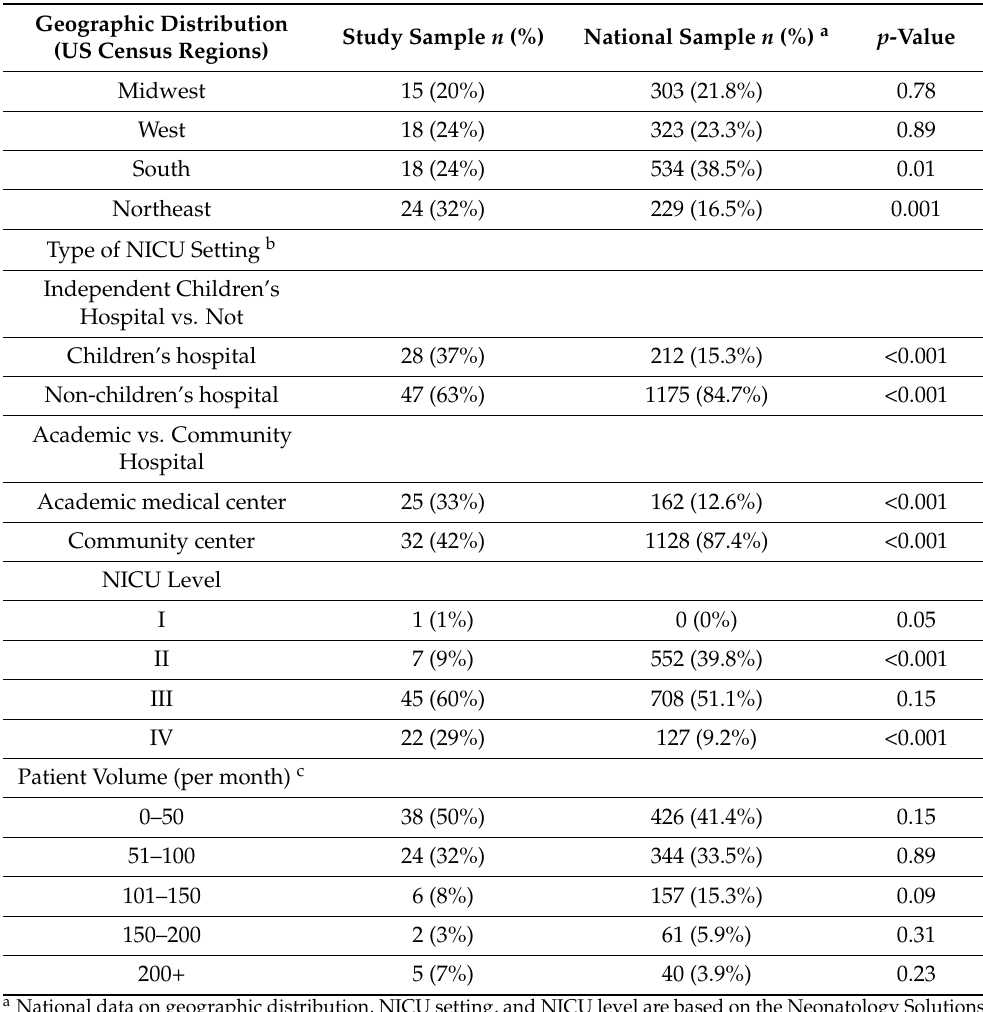
Table 2. Characteristics of participating NICU programs ( n =